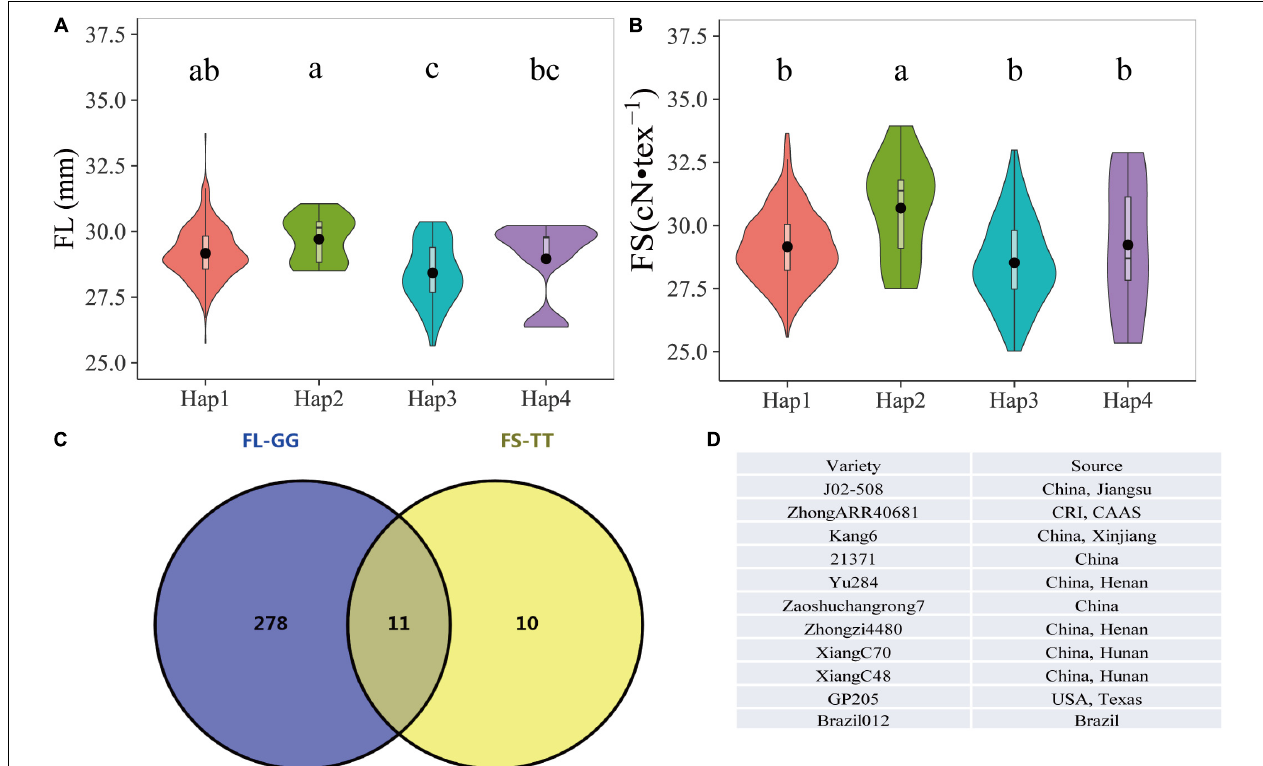
FIGURE 4 | The effects of four haplotypes on fiber length and fiber strength. (A) Average phenotypic data of fiber length in multiple environments. (B) Average phenotypic data of fiber strength in multiple environments. (C) Eleven elite accessions with Hap2 genotypes. (D) List of 11 elite accessions with Hap2. Different lower case letters above the plots represent Duncan’s multiple comparisons at P < 0.05.